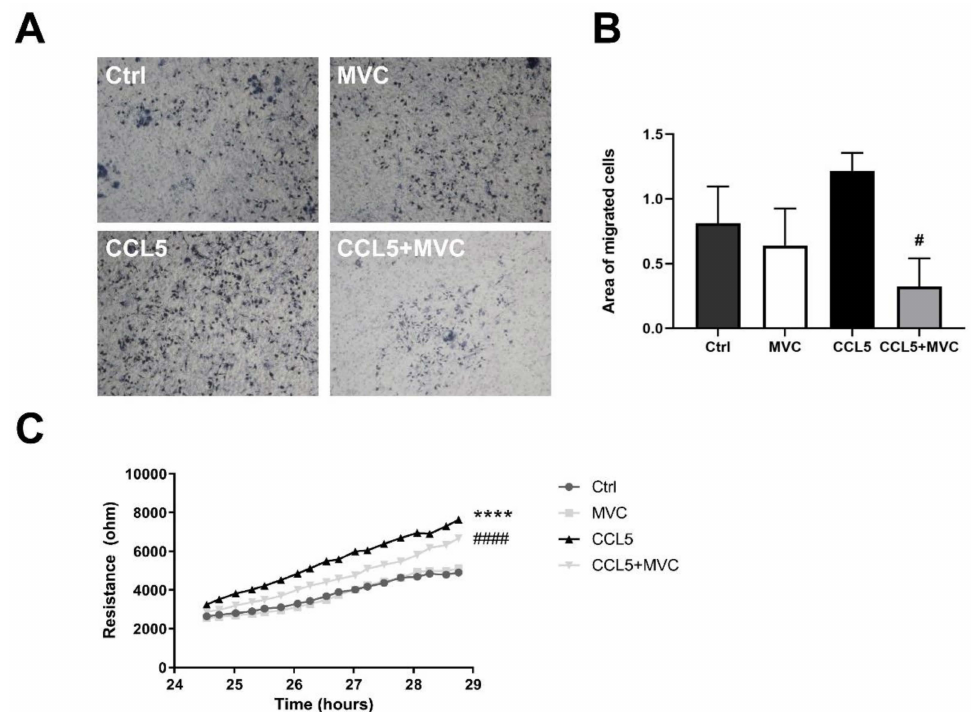
Figure 7. MVC reduces macrophage migration in vitro. ( A ) Transwell migration assay. BMMOs were seeded in the upper chamber of the Transwell ± MVC, and medium without serum but containing mCCL5 was placed in the well. Images display migrated crystal-violet-stained cells following a 24 h migration. Representative images are shown at 10x objective lens magnification. ( B ) Quantitation of the migration images by image thresholding. The bars represent the mean + SEM for n = 3, 4, 4 and 4 for the Ctrl, MVC, CCL5 and CCL5+MVC groups, respectively. ( C ) Resistance/impedance over time as measured by the cell migration after electric wounding (ECIS) apparatus. Resistance is proportional to wound closure, representative of cell migration. Cells were stimulated ( ± MVC and CCL5). Data shown are results from 4 different cell cultures. **** p < 0.0001 between Ctrl and CCL5, # p < 0.05, #### p < 0.0001 between CCL5 and